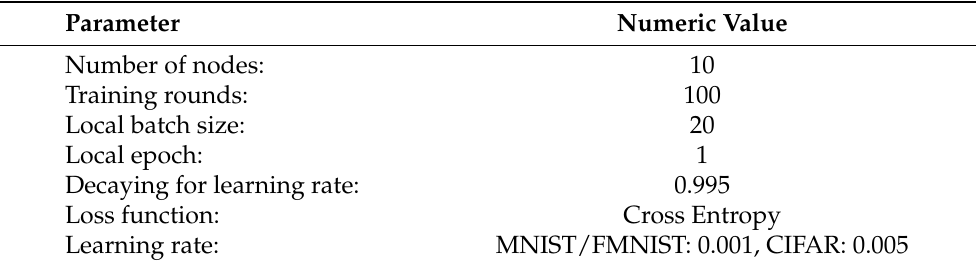
Table 2. Experimental parameters